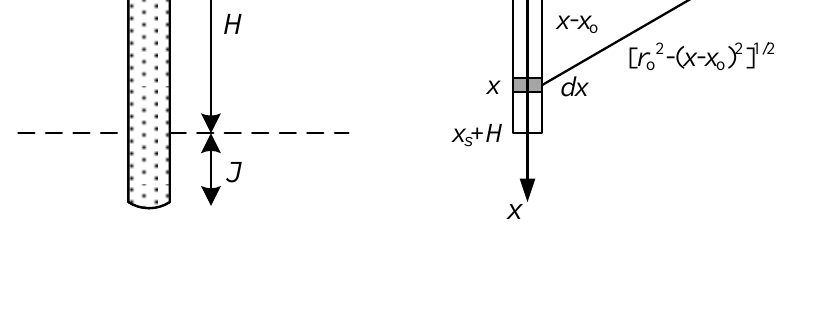
Figure 4. The explosive charge and